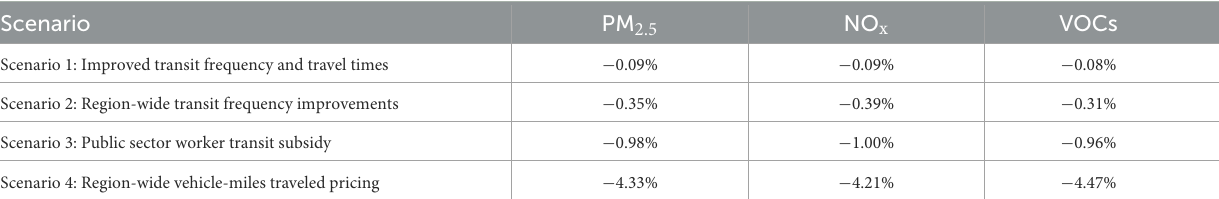
Scenario PM 2.5 NO x